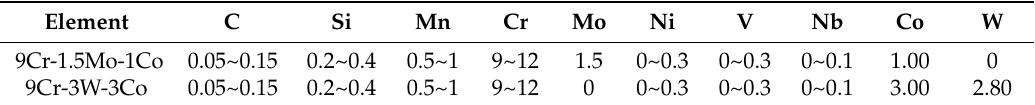
Table 1. Chemical composition of the steel,